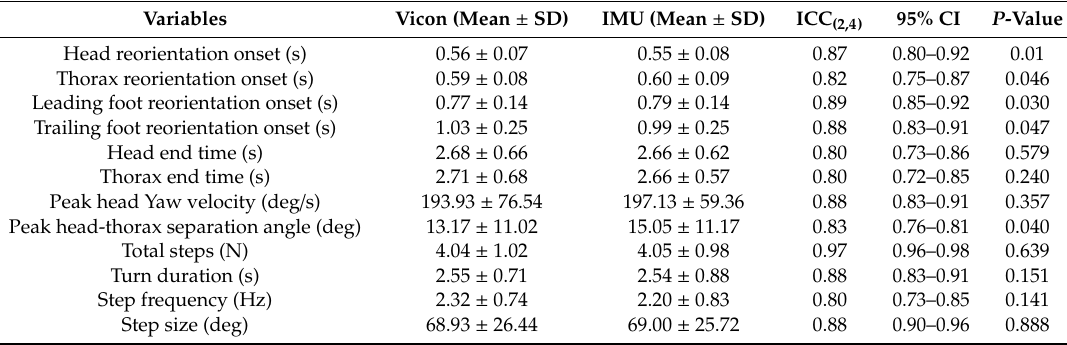
Table 2. The validity of Vicon motion analysis system and IMU measurement for all